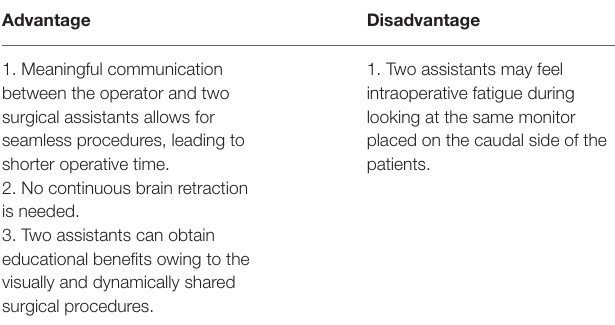
TABLE 1 | Advantages and disadvantages of the three-surgeon–six-hand operation using a 4K-3D exoscope.